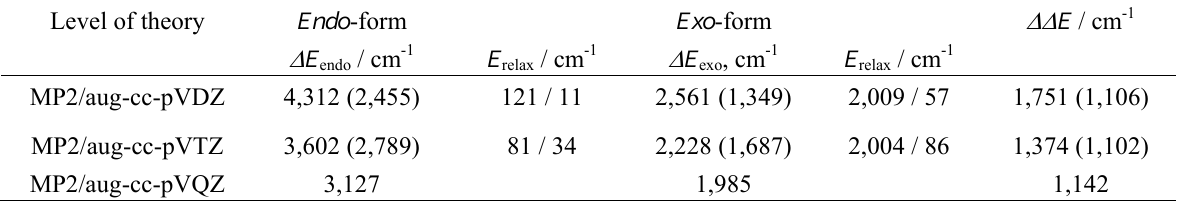
,  E ) and relative (  E =  E -  E ) energies (in cm -1 ) Table 4. Total binding (  E endo exo endo exo O) of the global minimum endo - and the local minimum exo -isomers of the C4A-(H 2 1 complex. Numbers in parentheses indicate BSSE-corrected numbers. The relaxation energies for C4A and water (distortion energy of the C4A and water moieties in the complex from their gas phase structures) are also denoted for the two